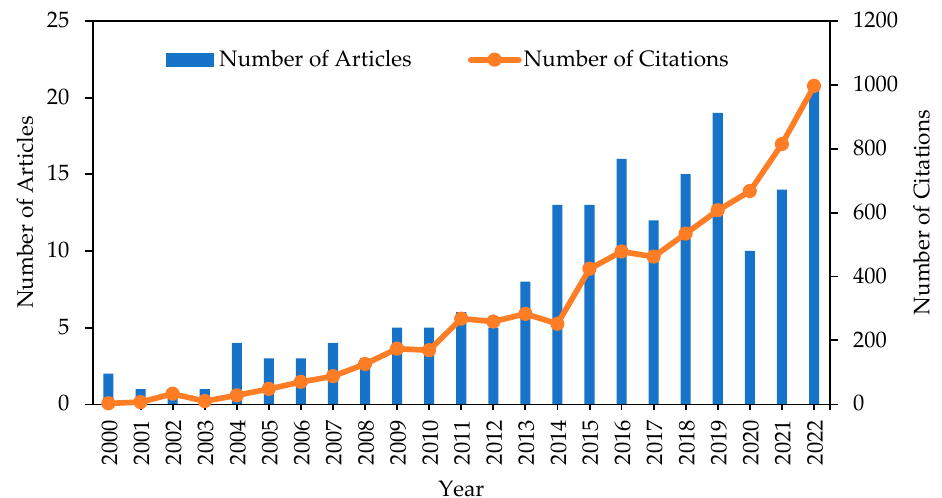
Figure 3. Number of articles and number of citations for articles published on the topic of bioH 2 production from microalgae.